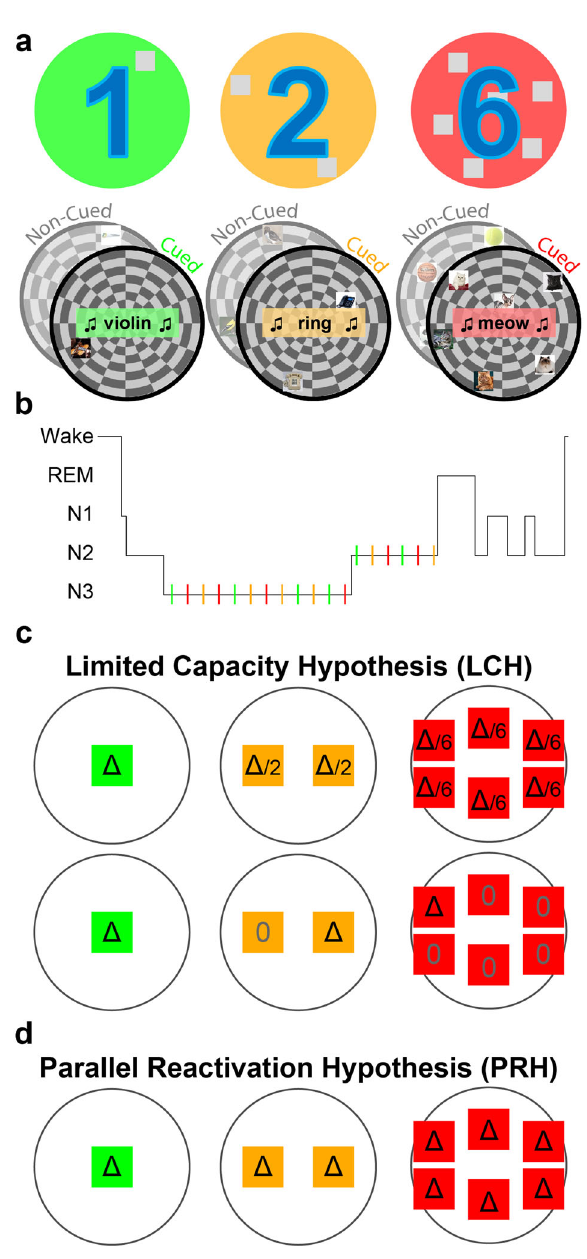
Fig. 1 Design and predictions. a In a spatial-memory task, participants learned the speci fi c locations of images that appeared on a circular grid. Images belonged to sets that included six images, two images, or one image (e.g., the cat set consisted of six distinct images of different cats whereas the phone set consisted of two phones). Each set was associated with a set- speci fi c sound (e.g., “ meow ” , “ ring ” ). Some sets were cued during subsequent sleep (colored sets) and others were not (gray sets). b Sounds were presented during stages N2 and N3 in an afternoon nap. c The limited capacity hypothesis (LCH) predicts that each item belonging to a large set would bene fi t less from TMR relative to items belonging to a smaller set. If a single-item set (green) receives a certain bene fi t ( Δ ), this bene fi t will be divided between items in the two-item set (orange) and the six-item set (green). This bene fi t could, for example, be split evenly between items (top) or designated to a single item of the set (bottom). Other variants of this hypothesis are explored in the main text. d The parallel reactivation hypothesis (PRH; center) predicts that the bene fi t per item would not depend on group size. Colors, symbols same as c